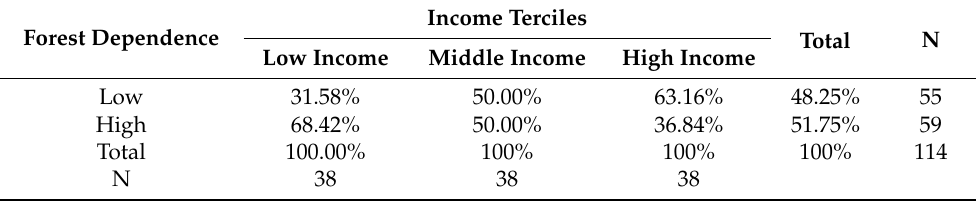
Table 4. Distribution of forest-dependent households by income tercile and level of forest dependence. Income Terciles Forest Dependence